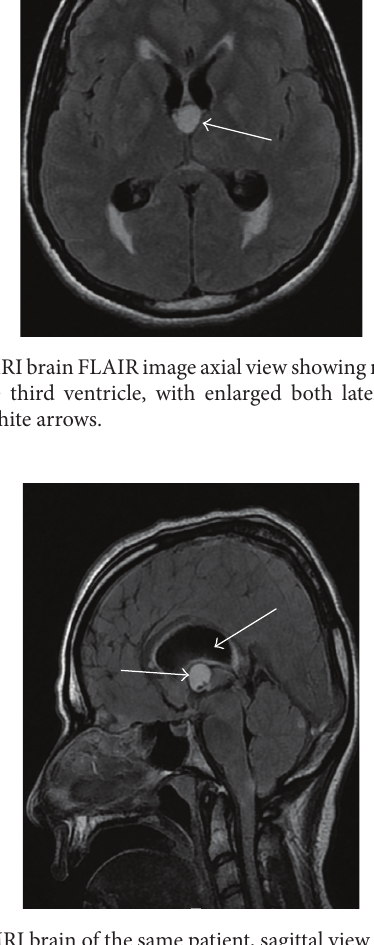
Figure 3: MRI brain of the same patient, sagittal view showing oval mass in the third ventricle at foramen of Monro, with hydrocephalus shown by